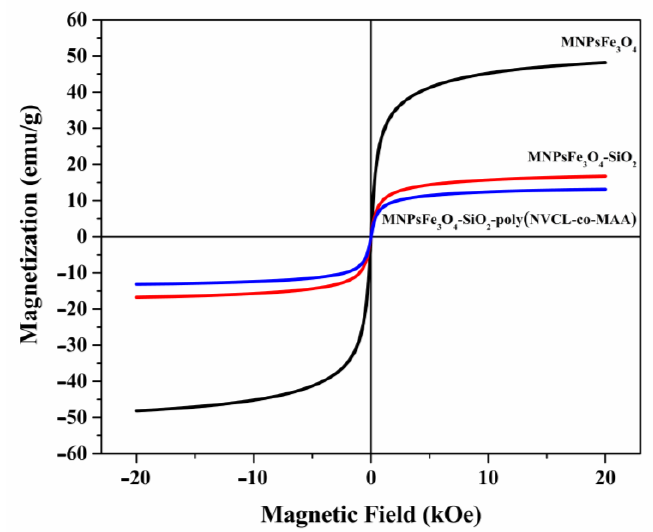
Figure 5. Magnetization curves of MNPsFe 3 O 4 , MNPsFe 3 O 4 -SiO 2 , and MNPsFe 3 O 4 -SiO 2 -poly (NVCL-co-MAA) nanocomposites.